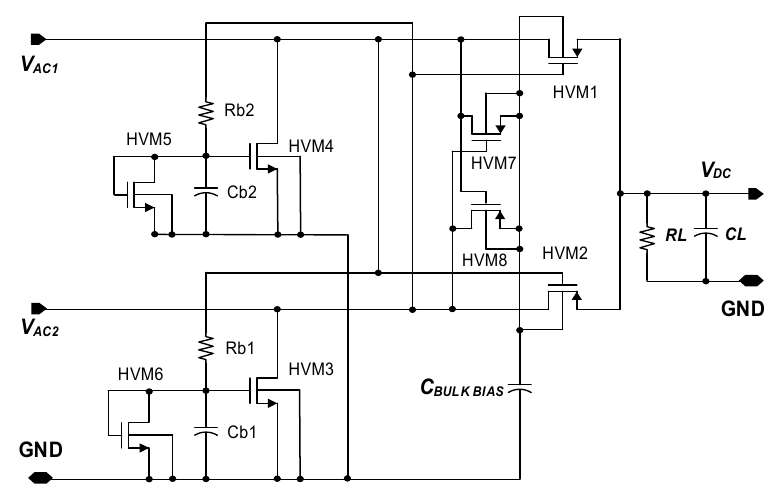
Figure 3. Circuit schematic of the proposed high-voltage